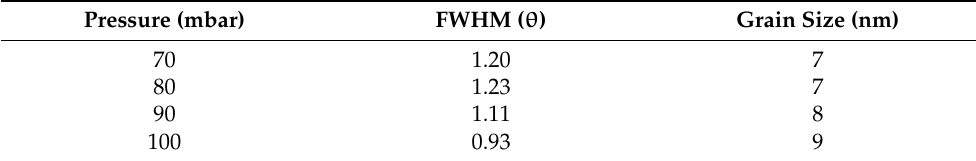
Figure 1. XRD diffractograms for N-UNCD films grown at different total pressures, keeping the microwave power constant at 4500 W. Table 2. Grain sizes of N-UNCD films vs. film growth pressure.